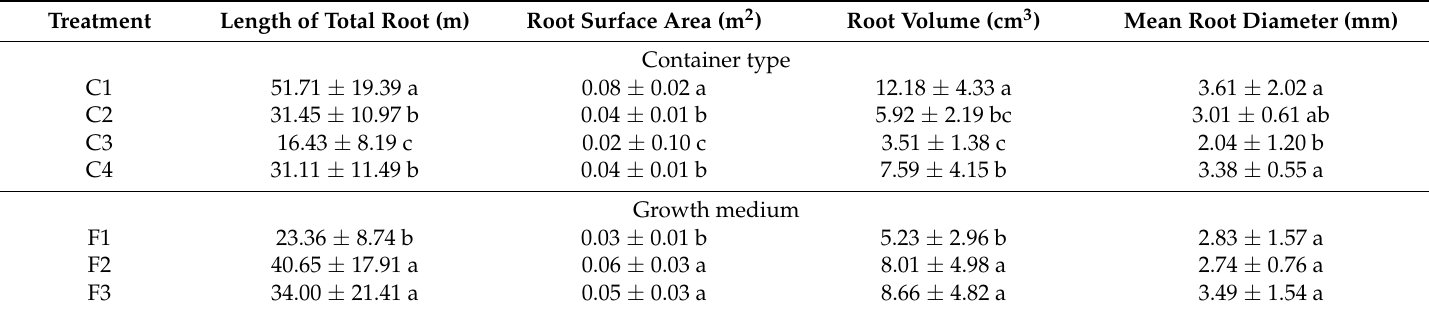
Table 5. The effect of container type and growth medium on root parameters of Cyclocarya paliurus container